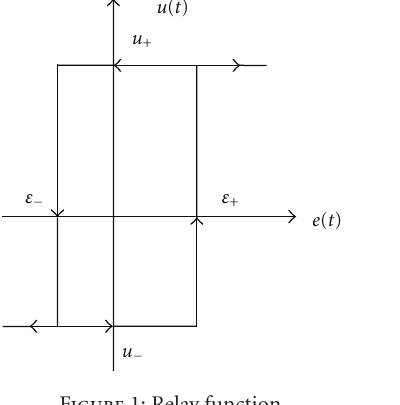
Figure 1: Relay function.